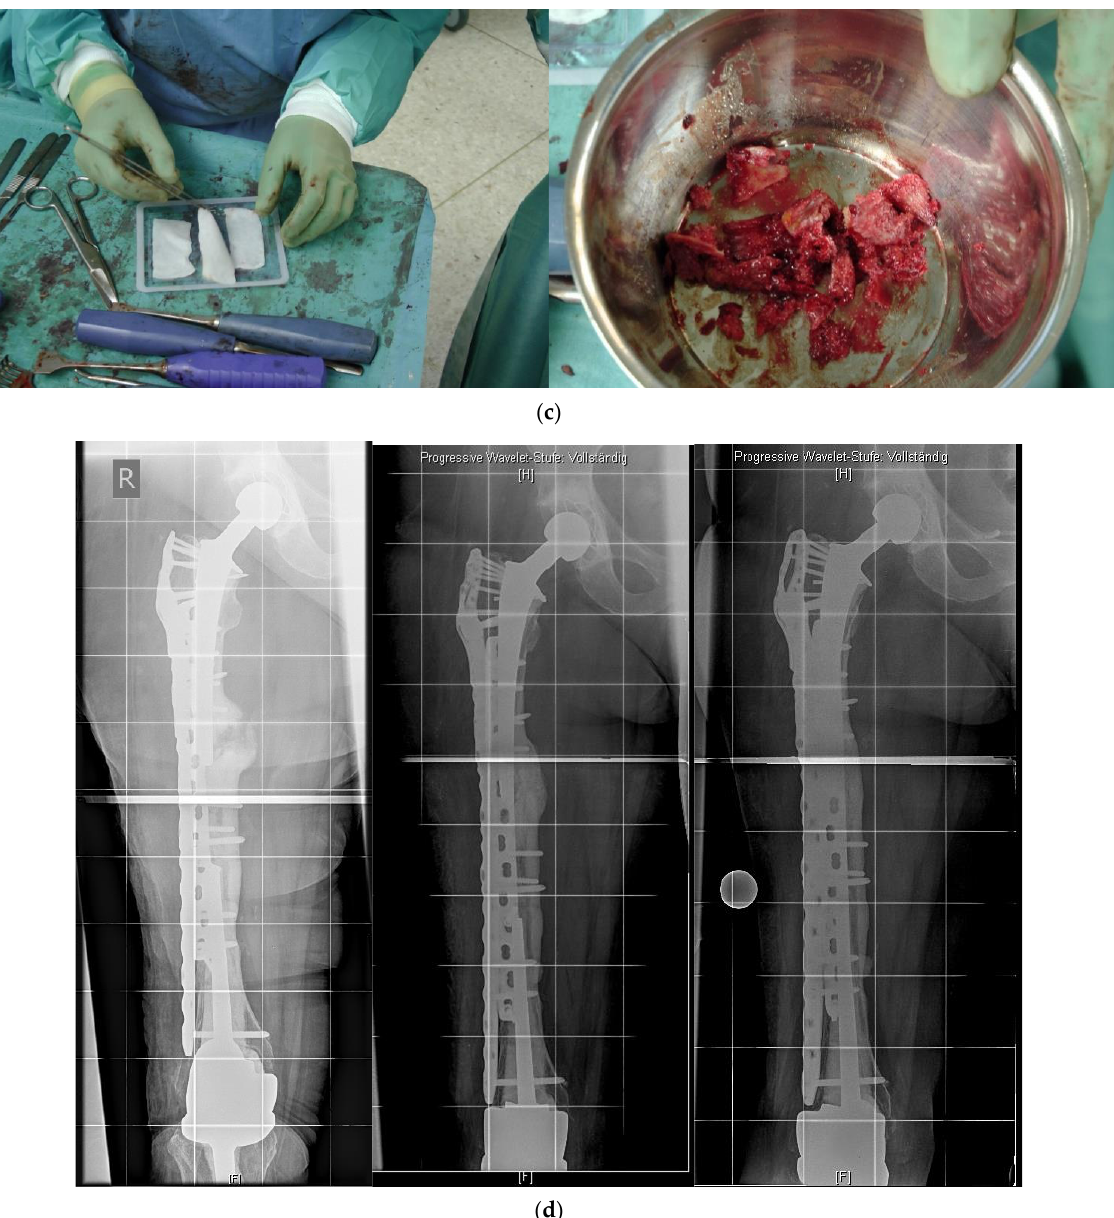
Figure 4. ( a ) Interprosthetic hypertrophic non-union. Intraoperative situs showing the failed plate fixation and the non-union. ( b ) Intraoperative situs showing the double plating. ( c ) Double plating combined with bone-grafting and growth factor application. ( d ) Postoperative follow-up X-rays after 6 weeks, 12, and 24 months, demonstrating complete healing and remodeling of the fracture.